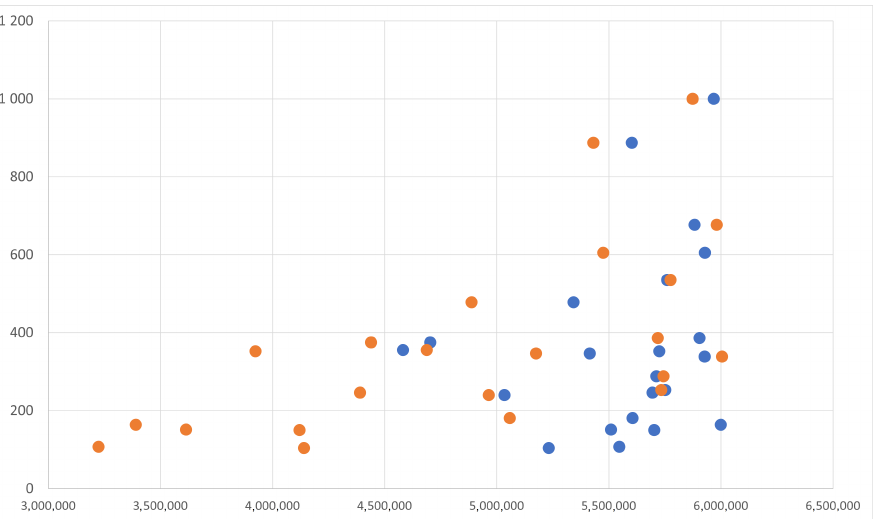
Figure 7. M × N (x-axis) versus computation time in seconds (y-axis). The orange dots takes into account when the uniform blocks are ignored from the